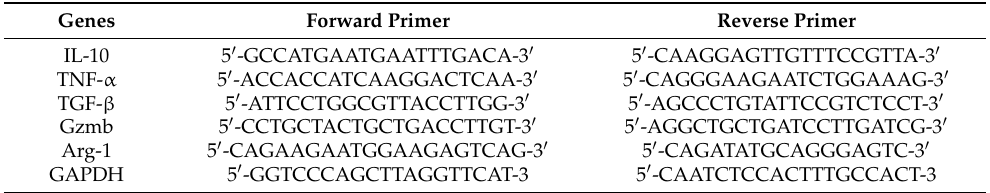
Table 1. Forward and reverse primers used in qPCR